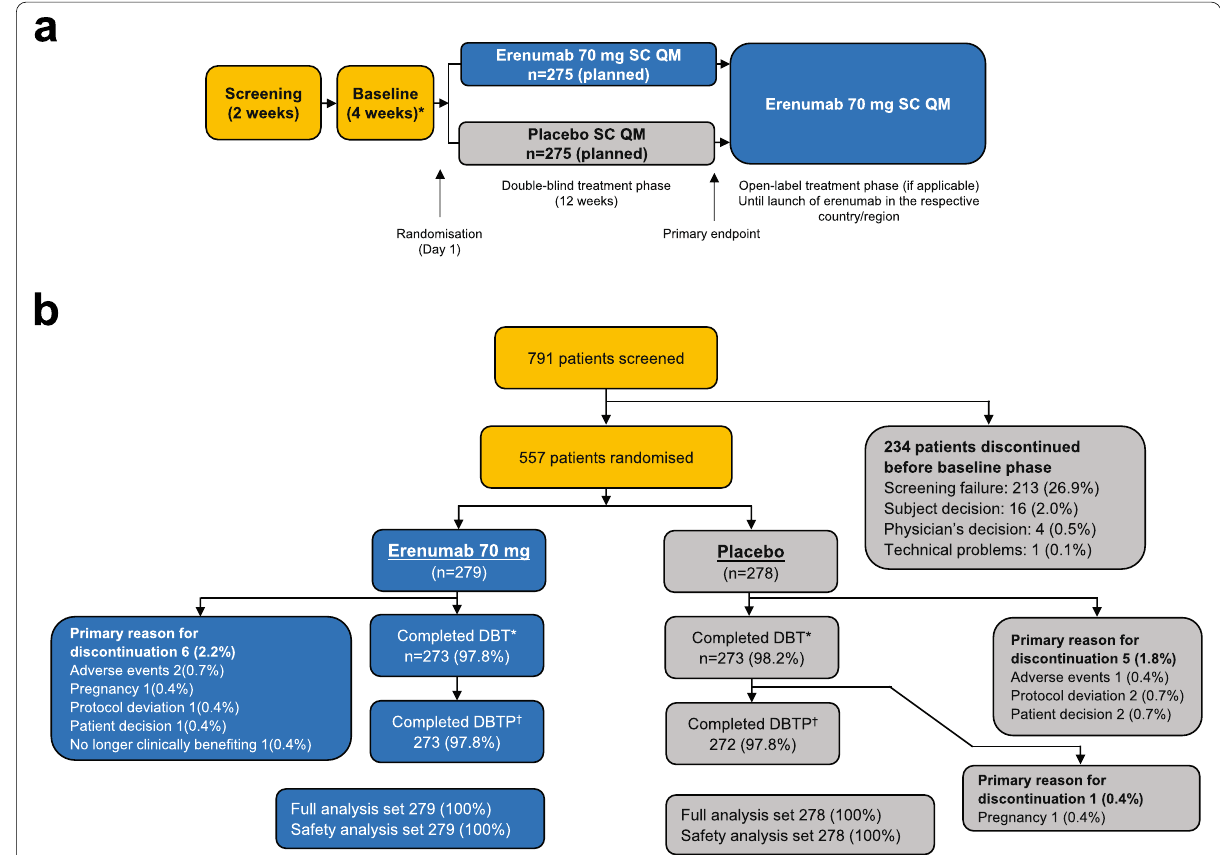
Fig. 1 a Study design. Note: For patients not entering the OLTP, the safety follow‑up visit occurred 12 weeks after the last dose of the DBTP. In the selected countries or regions, patients completing the DBTP on the study drug were eligible to participate in the OLTP (until launch of erenumab in the respective country or region). The study was powered only for the primary endpoint assessed in the overall population with an alpha level of 0.05. The endpoints were assessed as change from baseline over the last 4 weeks of the DBTP. * Duration of baseline was up to 35 days (5 weeks) due to COVID‑19, with the last 28 days of this period considered for the assessment of headache frequency (MMD). DBTP, double‑blind treatment phase; OLTP, open‑label treatment phase; QM, once monthly; SC, subcutaneous. b Patient disposition in the DBTP. Note: *A patient is defined as a completer for the DBT if the individual had received the Week 8 dose (erenumab or placebo). † A patient is defined as completer for the DBTP, if the individual had completed all scheduled visits in the DBTP, including Week 12 visit, or entered in the OLTP. For patients who continued to OLTP, the cut‑off was end of treatment. For patients who entered into the safety follow‑up after double‑blind treatment, the cut‑off is 11‑Aug‑2021 or end of study whichever is the earliest. Screened were those patients who had signed an informed consent form. Full analysis set comprised all randomised patients. DBT, double‑blind treatment; DBTP, double‑blind treatment phase; OLTP, open‑label treatment